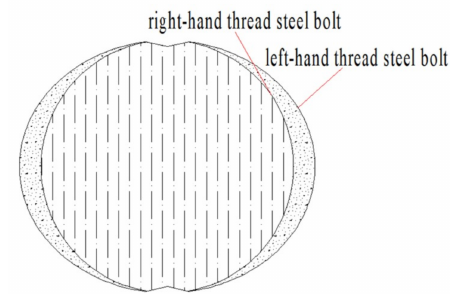
Figure 10. The effective tensile section area of left-hand and right-hand threaded steel bolt.